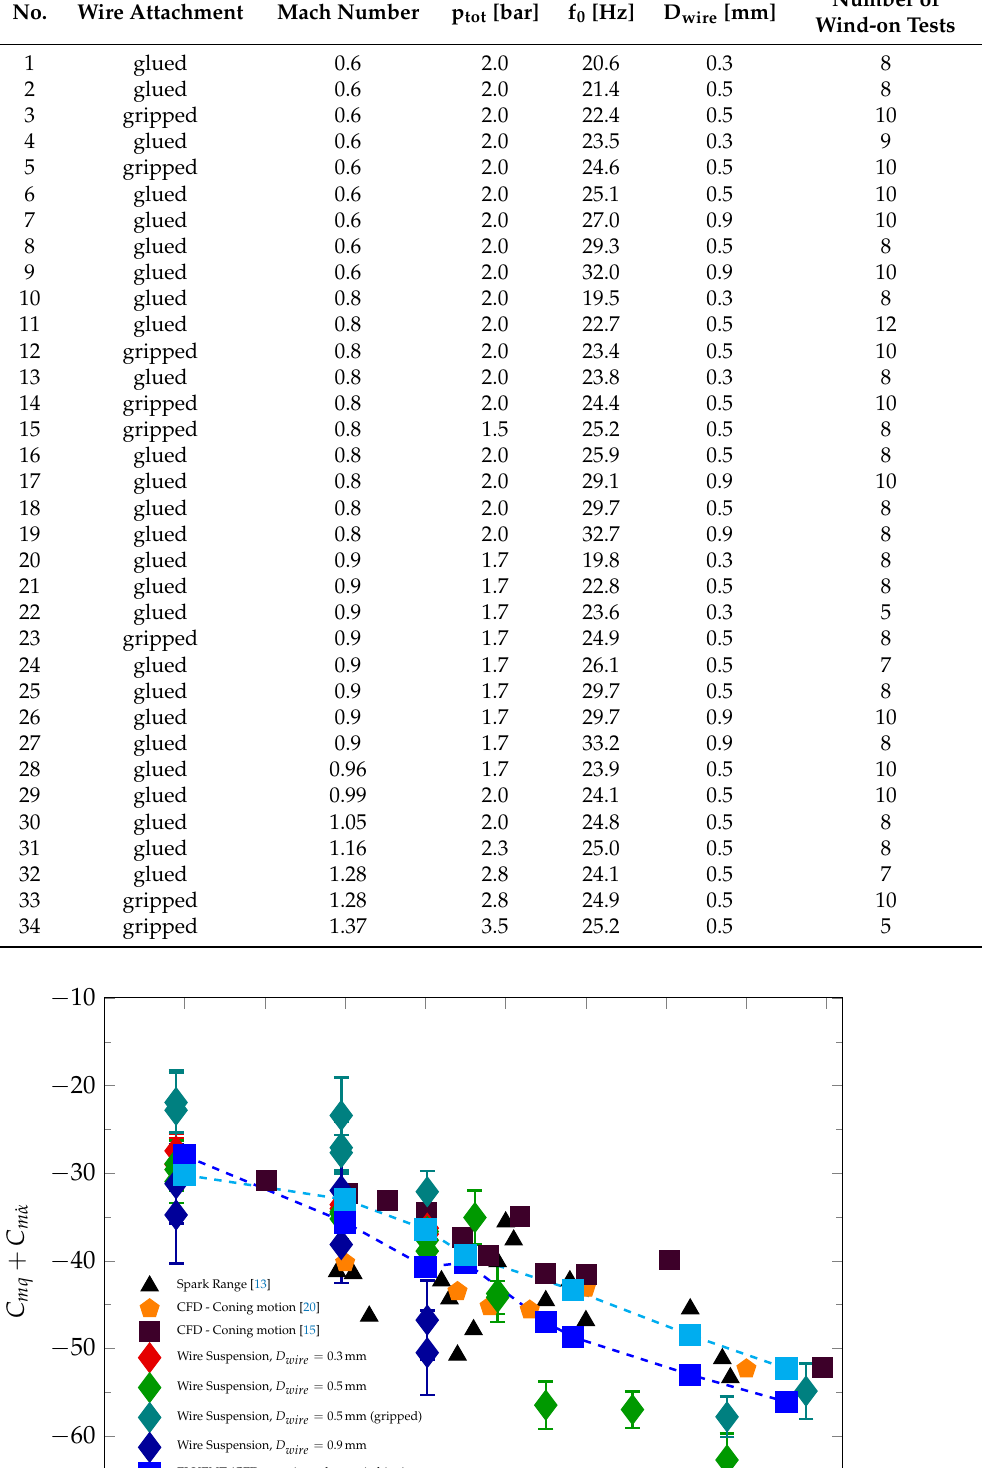
Table 2. Test case conditions for the ANSR model.